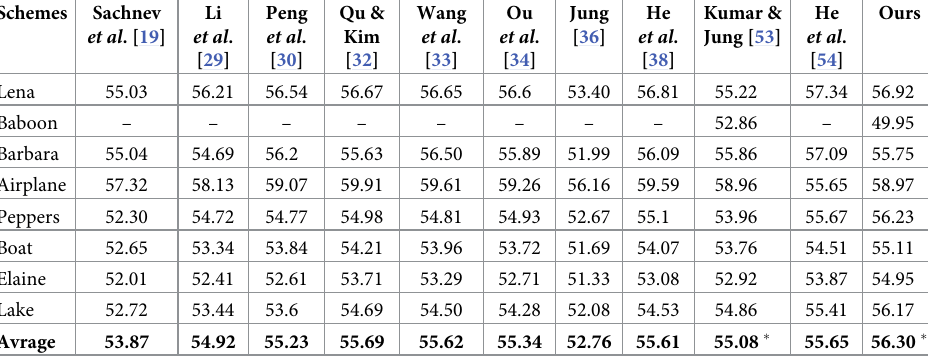
Table 4. PSNRs (dB) for embedding 20,000 bits in the USC-SIPI images.